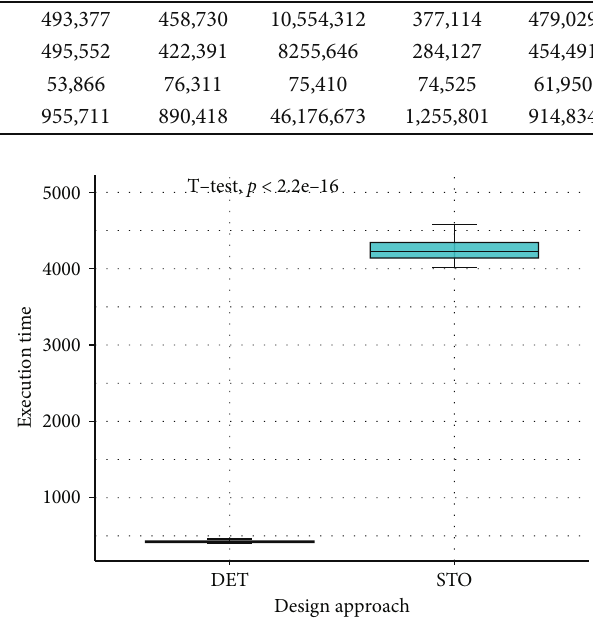
Figure 21: Comparison of design methodology based on execution